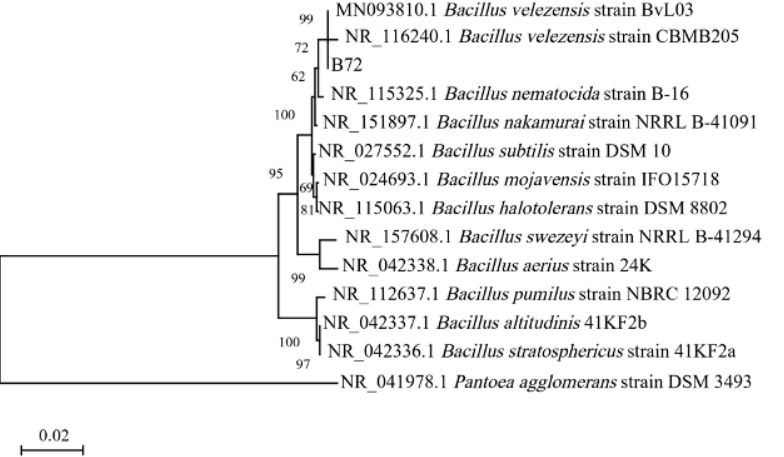
Figure 5. The phylogenetic tree of B72 strain.